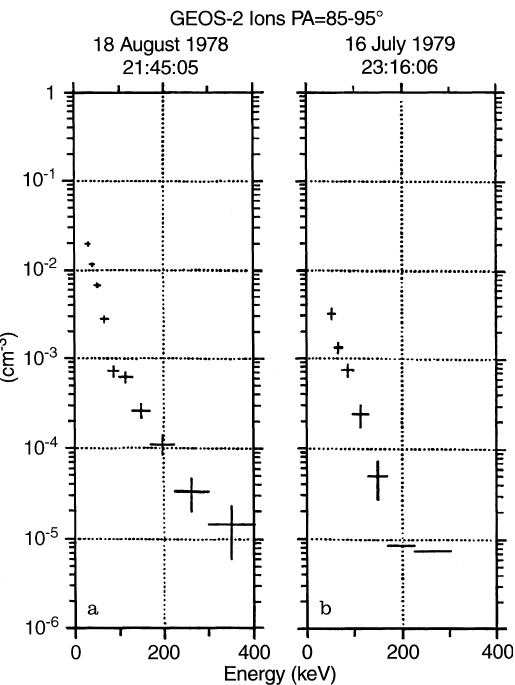
Fig. 2a,b. Examples of 90 (cid:14) pitch angle ion spectra as measured by S321 on GEOS 2; a for 18 August 1978 and b for 16 July